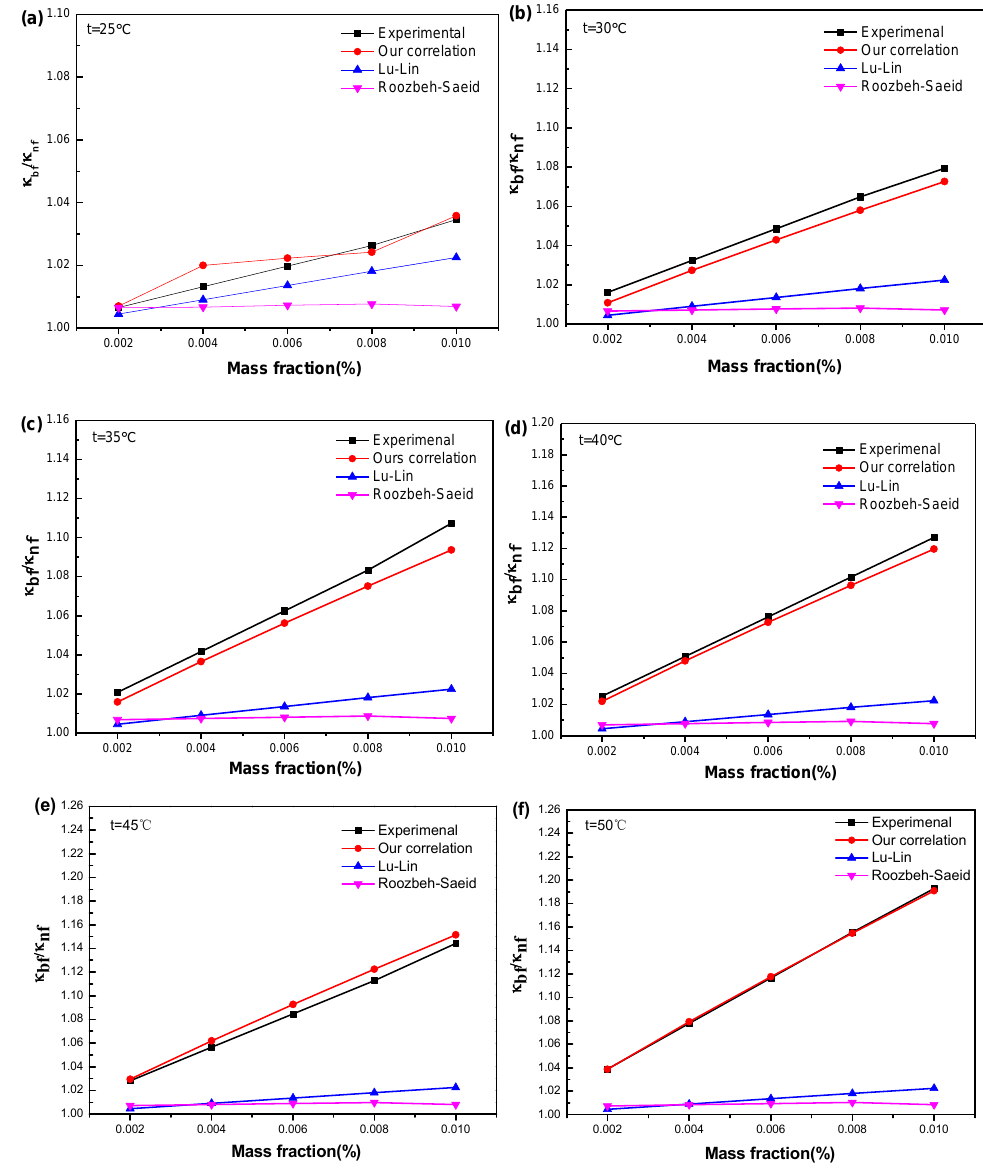
Figure 7. Comparison of experimental data for GO/DI-water-based nanofluids with results from models. ( a – f ) under temperature of 25, 30, 35, 40, 45 and 50 °C, respectively.